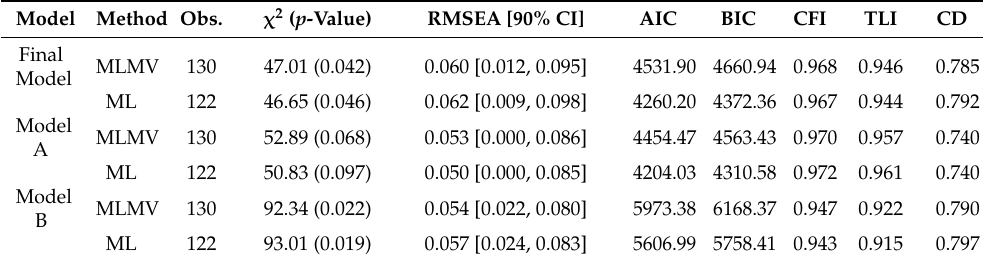
Table 3. Goodness of fit statistics for structural equation models testing the hypothesised association between physical activity, physical fitness, executive functions, and academic achievement ( n =